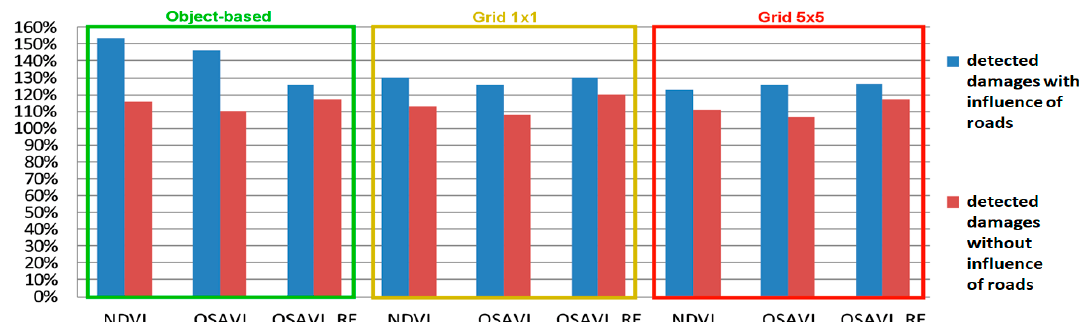
Figure 11. Area index (AI) in three approaches with 10 cm resolution of input data.